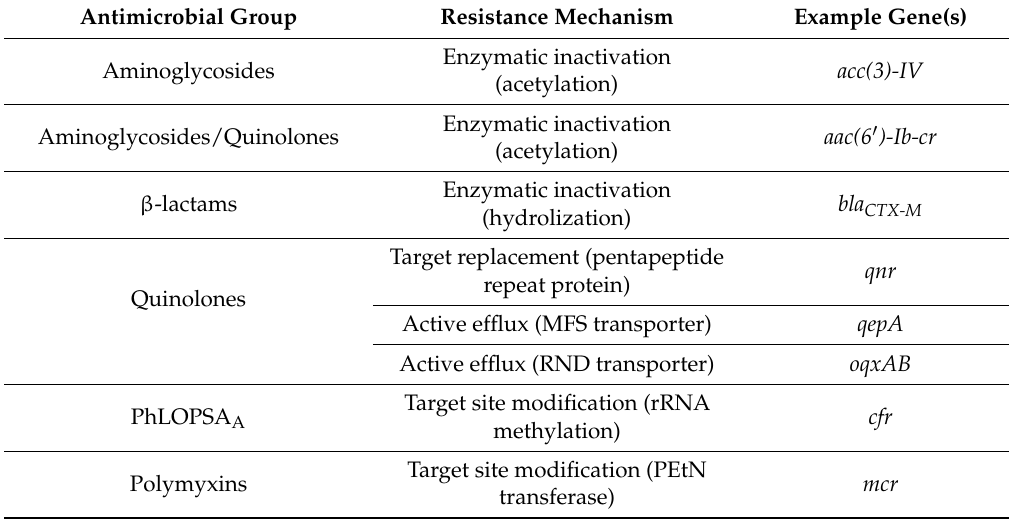
Table 7. Examples of important plasmid-associated resistance mechanisms in Enterobacteriaceae from